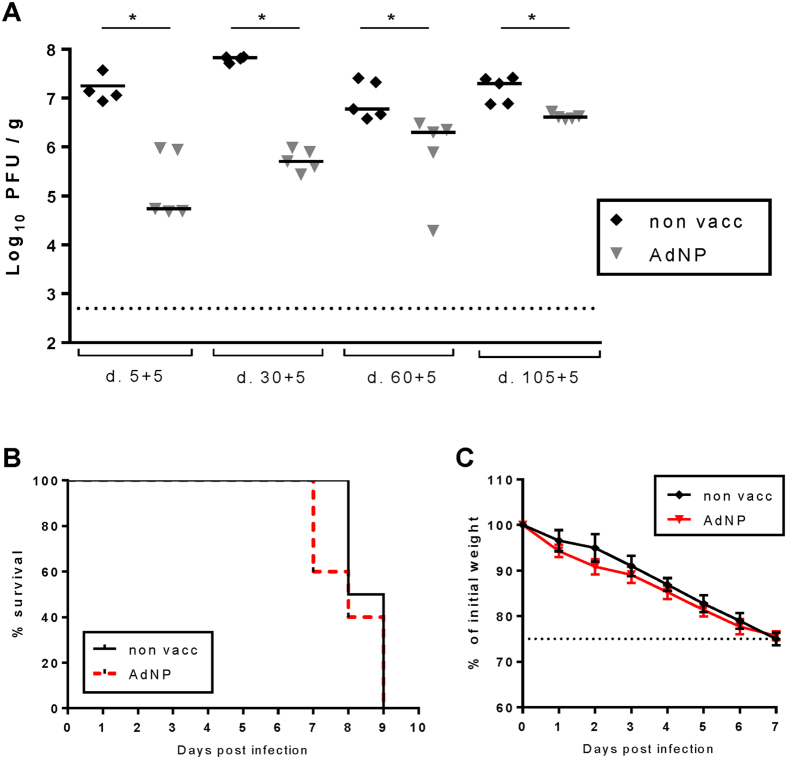
Vaccine-induced protection as a function of time after vaccination.C57BL/6 mice were vaccinated subcutaneously with 2 × 107 PFU of AdNP and 5, 30, 60 or 105 days later challenged with PR8 virus. (A) Five days post challenge, lungs were isolated and viral titers were determined using an MDCK plaque assay. Each dot represents one mouse and lines represent medians. Dotted line represents detection level for the assay. (B–C) Line graphs showing survival (B) and weight loss (C) of vaccinated mice challenged with PR8 virus 120 days later. Animals were monitored daily and euthanized if the weight loss exceeded 25%. The dots represent the means and bars SEMs. The dotted line represents the humane end point (25% weight loss). *p < 0.05